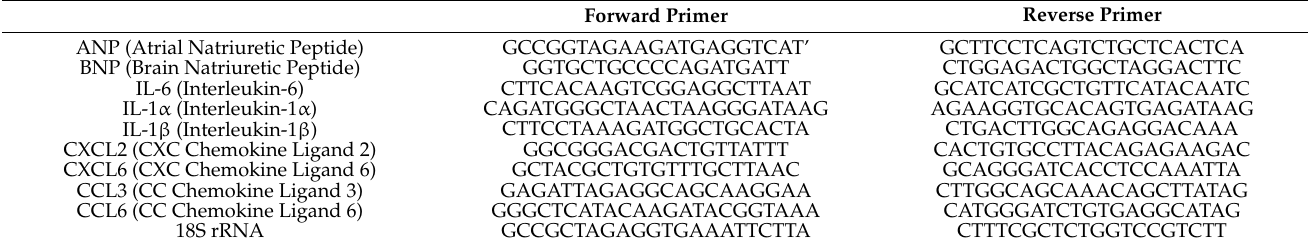
Table 2. Primers for qPCR Validation.